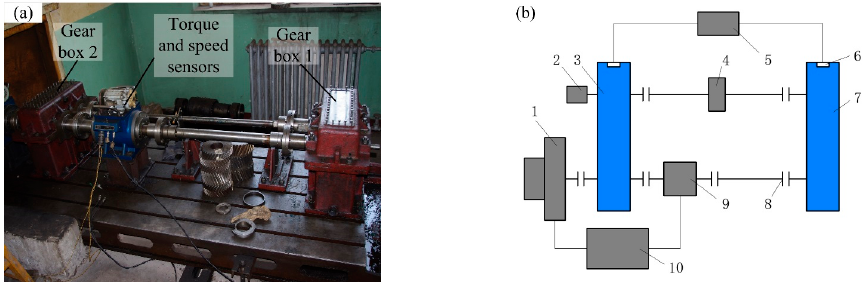
Figure 1. Closed electric power streaming gear test machine: ( a ) test rig and ( b ) schematic diagram of test rig: 1—motor, 2—counter, 3—gear box 2, 4—loader, 5—oil temperature indicator, 6—thermocouple, 7—gear box 1, 8—coupling, 9—speed and torque sensor, and 10—control cabinet.